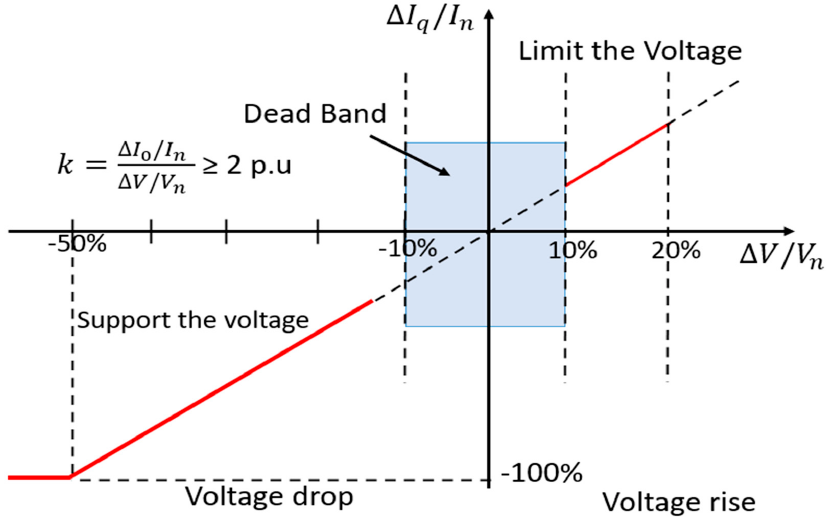
Figure 8. Dynamic reactive current regulations during the disturbance [35]. PMSG-FRT Requirements